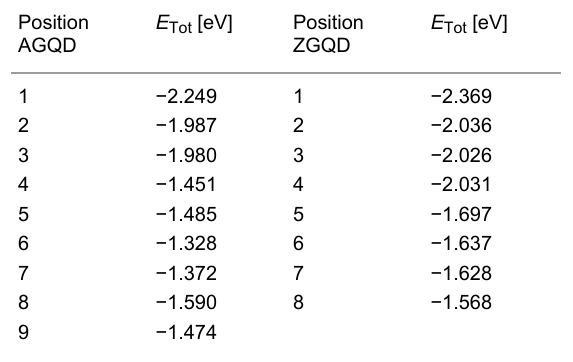
Table 1: Total energy of the graphene flakes decorated with a Ru atom. The Ru atom was put on 9(8) sites with nonequivalent symmetry on armchair (zigzag) graphene flakes. The sites are numbered according to Figure 1b. As a zero-point system the corresponding flake was chosen with a Ru atom placed 100 Å away from the flake